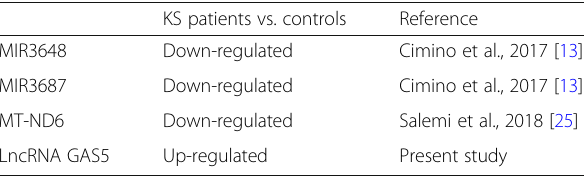
Table 1 Differently-expressed transcripts in patients with Klinefelter syndrome (KS) and controls KS patients vs.